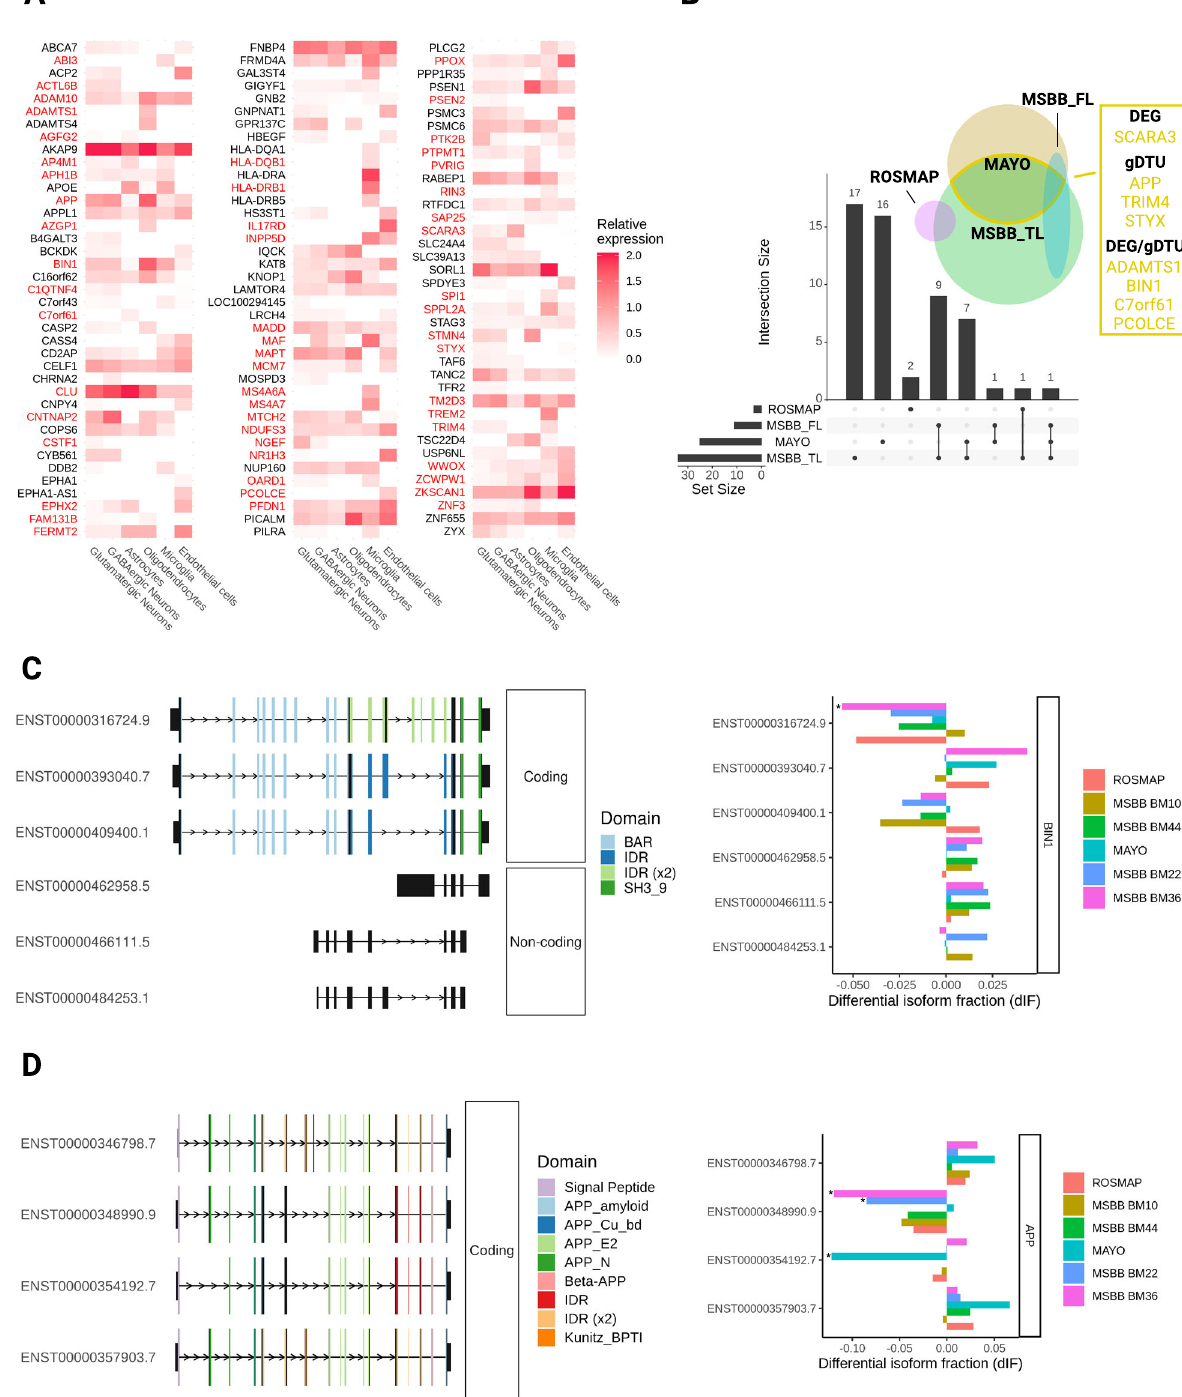
Fig. 8 Expression of AD risk/causal genes is mostly altered in the TL of patients. A Heatmap showing the expression of predicted AD risk/causal genes in different cell types of the adult human brain. DEGs and gDTUs in at least one dataset are highlighted in red. B Venn diagram showing the number of AD risk/causal DEGs or gDTUs identi fi ed in the different datasets analyzed. The intersection between Mayo and MSBB TL is highlighted in yellow, and genes identi fi ed are shown in the yellow box. C Representation of the 6 most signi fi cant BIN1 isoforms altered (left) and quanti fi cation of the differential isoform fraction (dIF) in AD brains compared to controls (right). Main protein domains are indicated with different colors. D Similar representation for APP. * dIF >0.05 and FDR > 0.01.